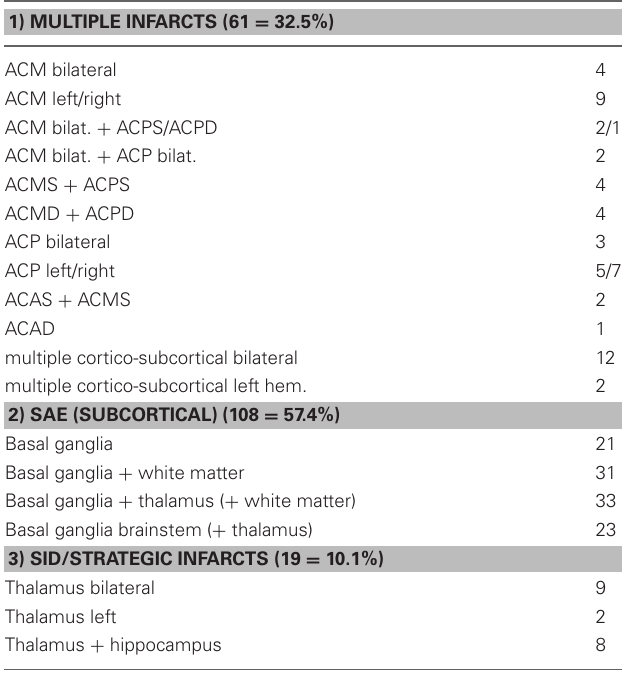
Table 10 | Types and location of cerebrovascular lesions in mixed dementia ( n = 83; personal